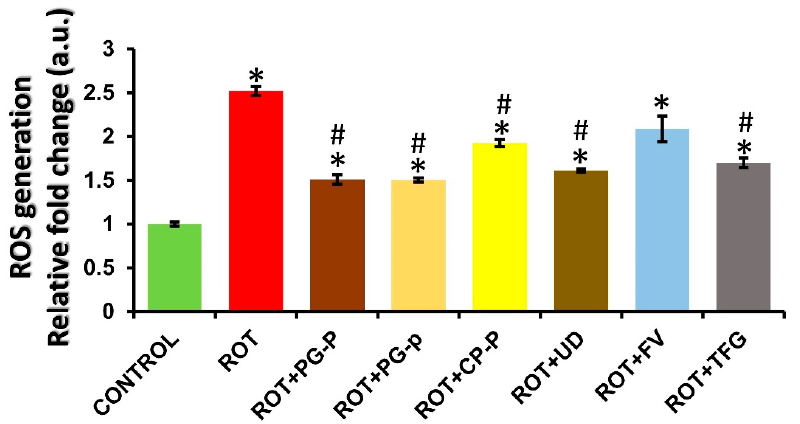
Figure 2. Drosophila third instar larvae exposed to ROT and ROT cotreated with plant extract for only 24 h showed a relative fold shift in ROS production. ROS generation was examined in control, ROT, and ROT along with phytoextracts groups (pomegranate peel (PG-P), pomegranate pulp (PG- p), papaya peel (CP-P), nettle leaves (UD), fennel (FV), and fenugreek (TFG)). All observations are expressed as the mean ± SEM, n = 3, with each group having 50 larvae per vial, and were performed 3 times. Significance was ascribed to * p < 0.05 compared to the control; # p < 0.05 compared to rotenone.